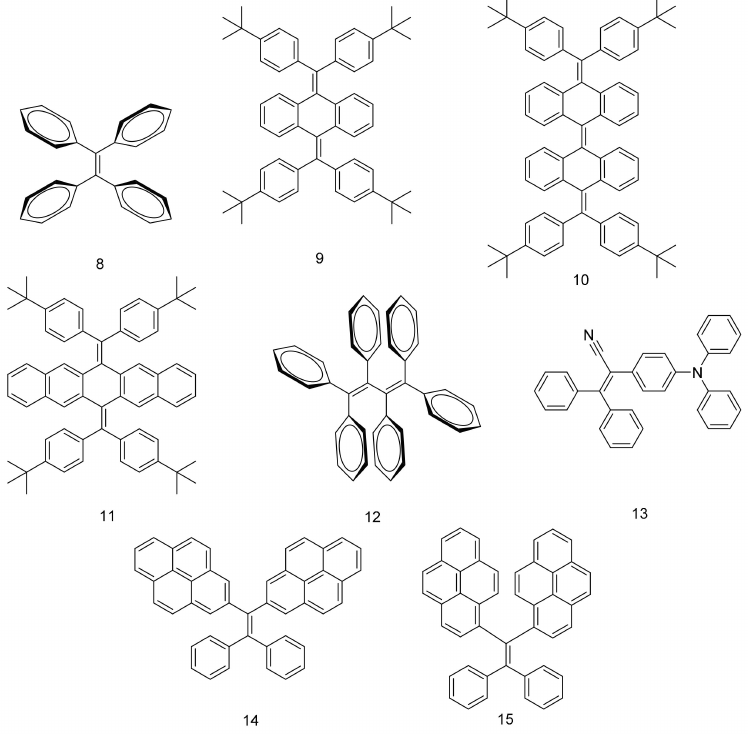
Figure 5. Structures of molecules 8 – 15 containing rotors in LSC applications.